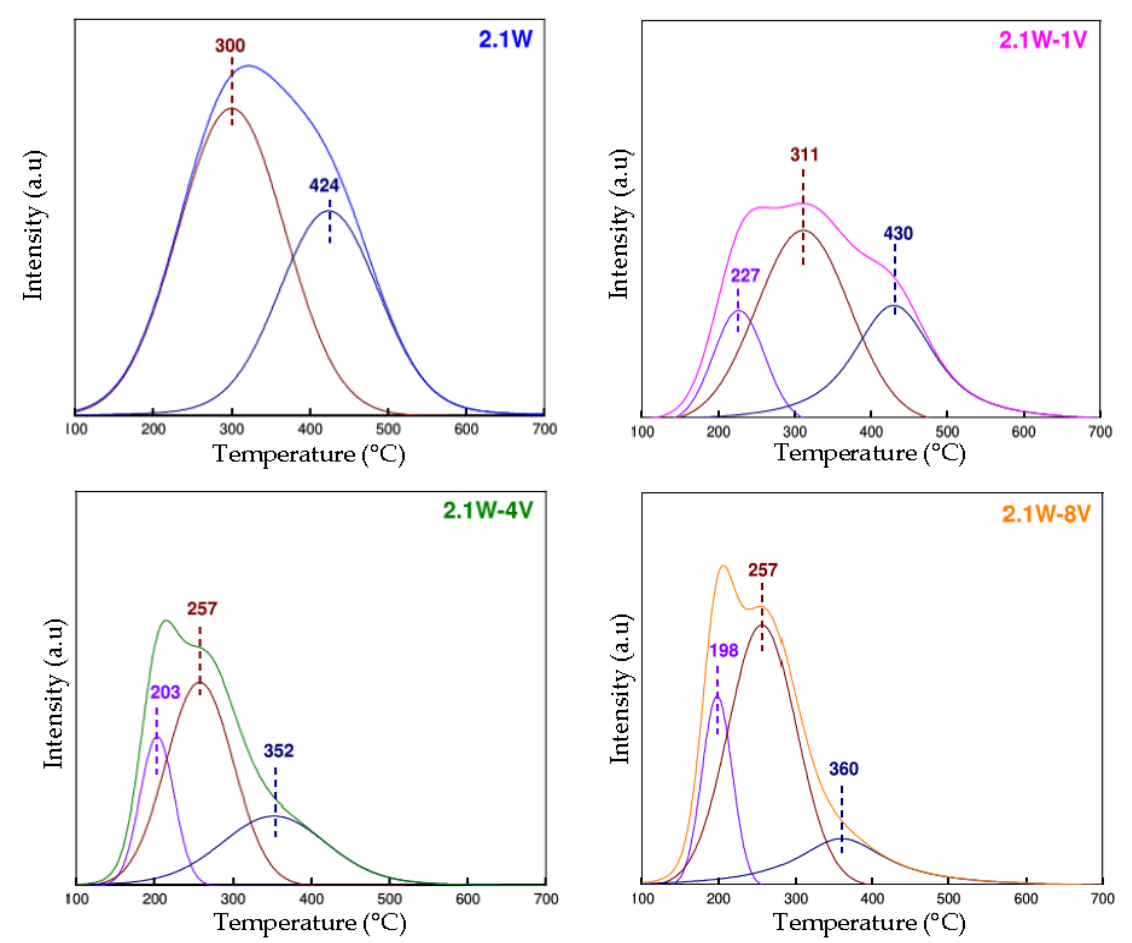
Figure 10. Normalized ammonia-TPD profiles recorded for 2.1W- x V: impact of V loading on the acidic functionality.